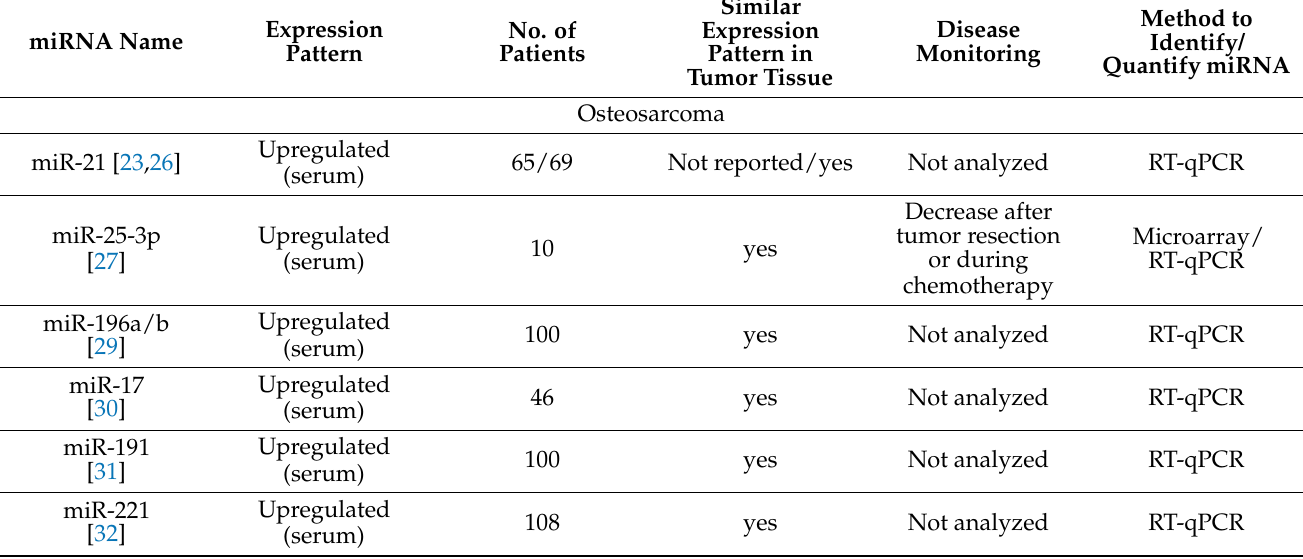
Table 1. List of miRNAs identified in sarcoma body